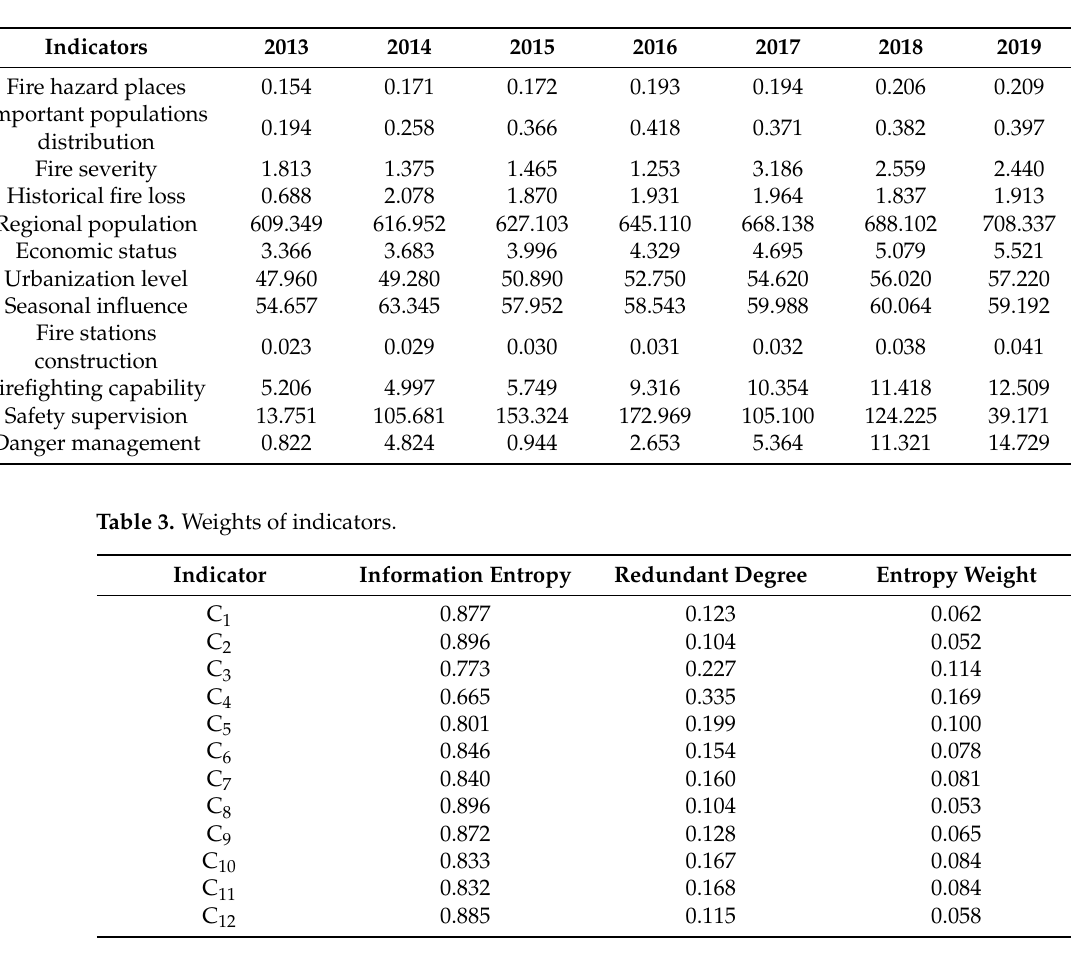
Table 2. Urban fire risk evaluation index values.